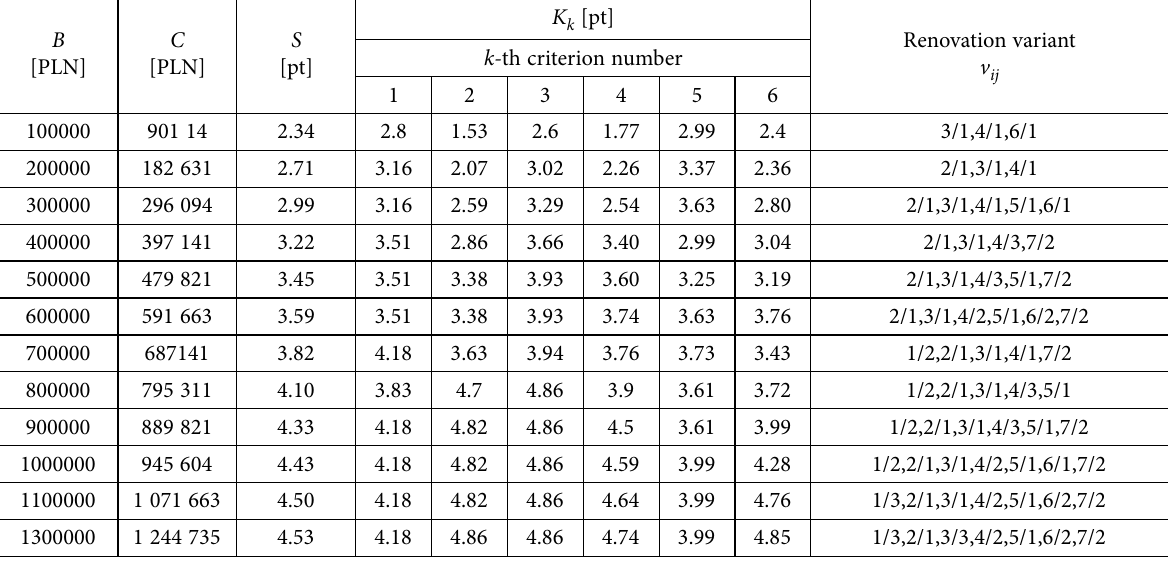
Table 3. The achieved values of building condition index S for the assumed budget amounts B .